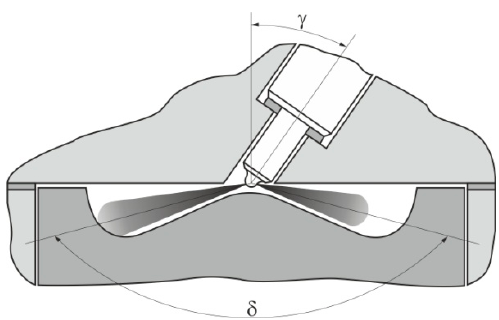
Figure 1. Installation of a fuel injector with a slope angle γ in a diesel engine.